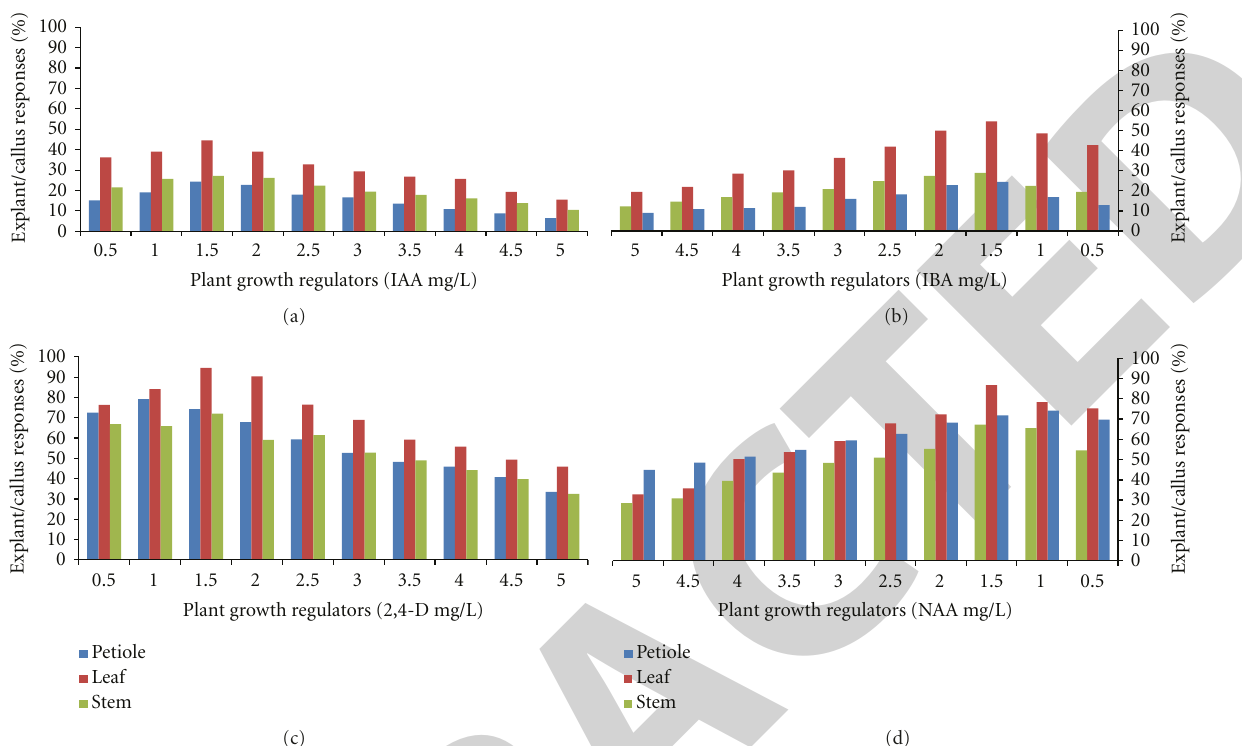
Figure 3: E ff ect of MS medium supplemented with auxins and petiole, leaf, stem explants role on callus induction (%) of Gymnema sylvestre after 45th day of